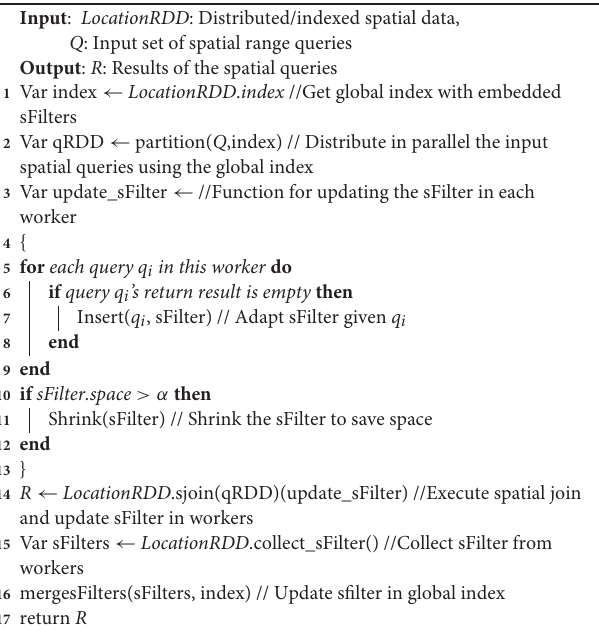
Algorithm 2 : Update sFilter in